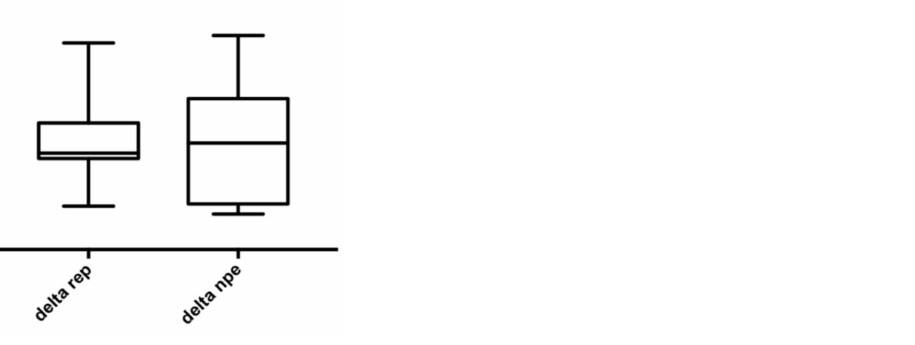
Figure 5. Posterior width. Delta REP is the variation in patients treated with RPE; Delta NPE-2 is the variation in patients treated with NPE-2; the numbers show the variation measured in millimeters.